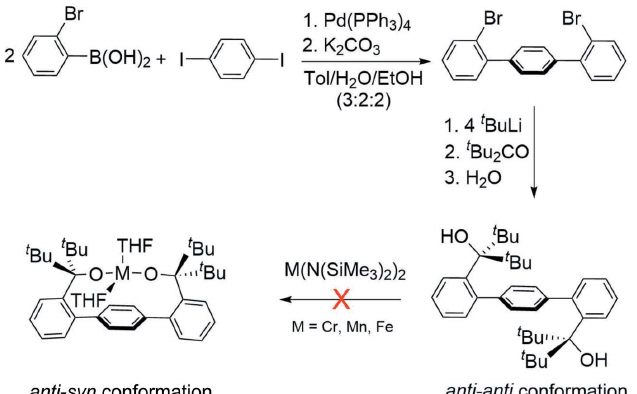
Figure 2 Synthesis of H 2 [OO] tBu , its schematic structure, and the lack of well- defined reactivity with transition-metal amide precursors.